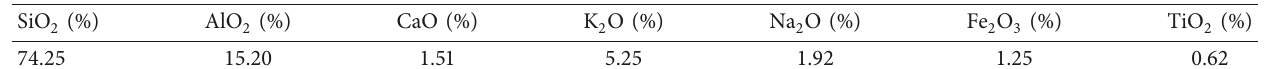
Table 2: Components of the sand.